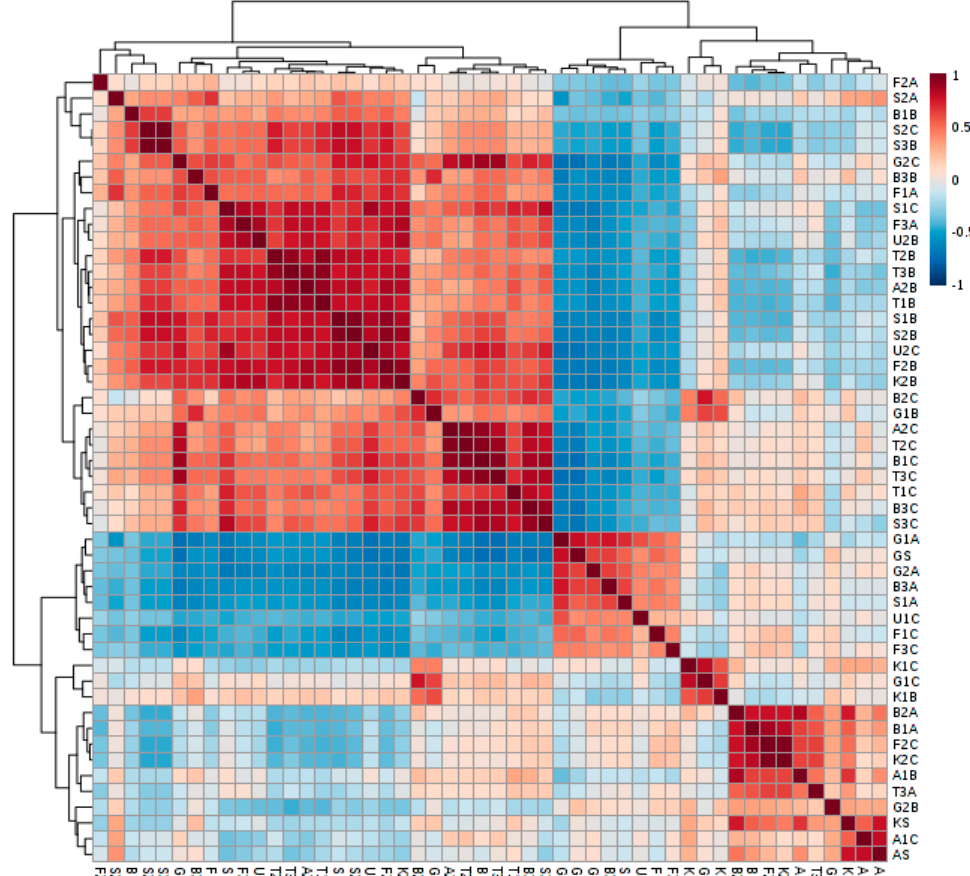
Figure 1. Heatmap showing the correlation of the samples. Positively correlated samples are shown in brown color and negative in blue. Bloukrans River samples: B1A (upstream, autumn); B2A